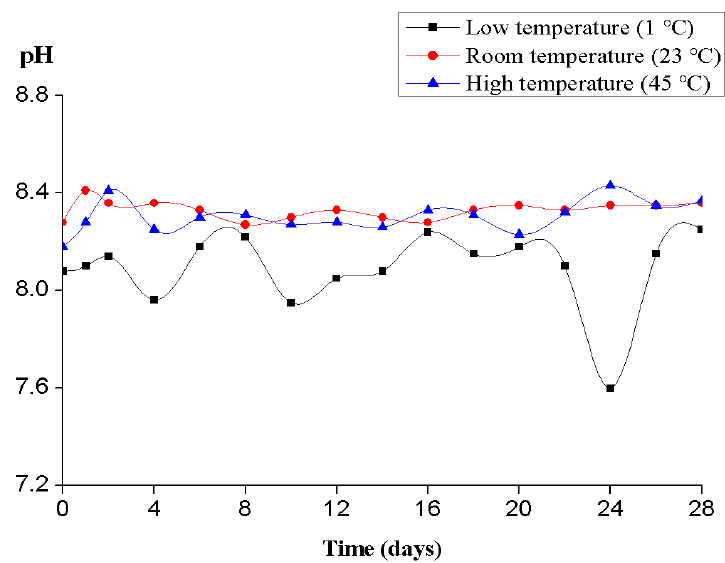
Figure 5. Change diagram of the pH of the circulating aqueous solution in turbulent flow at different temperatures. Changes in the main anodic and cationic concentrations.